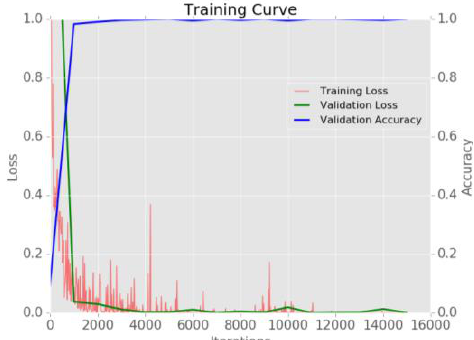
Figure 2: Learning curve (red curve: training Loss, green curve: Validation Loss, blue curve: Validation accuracy)